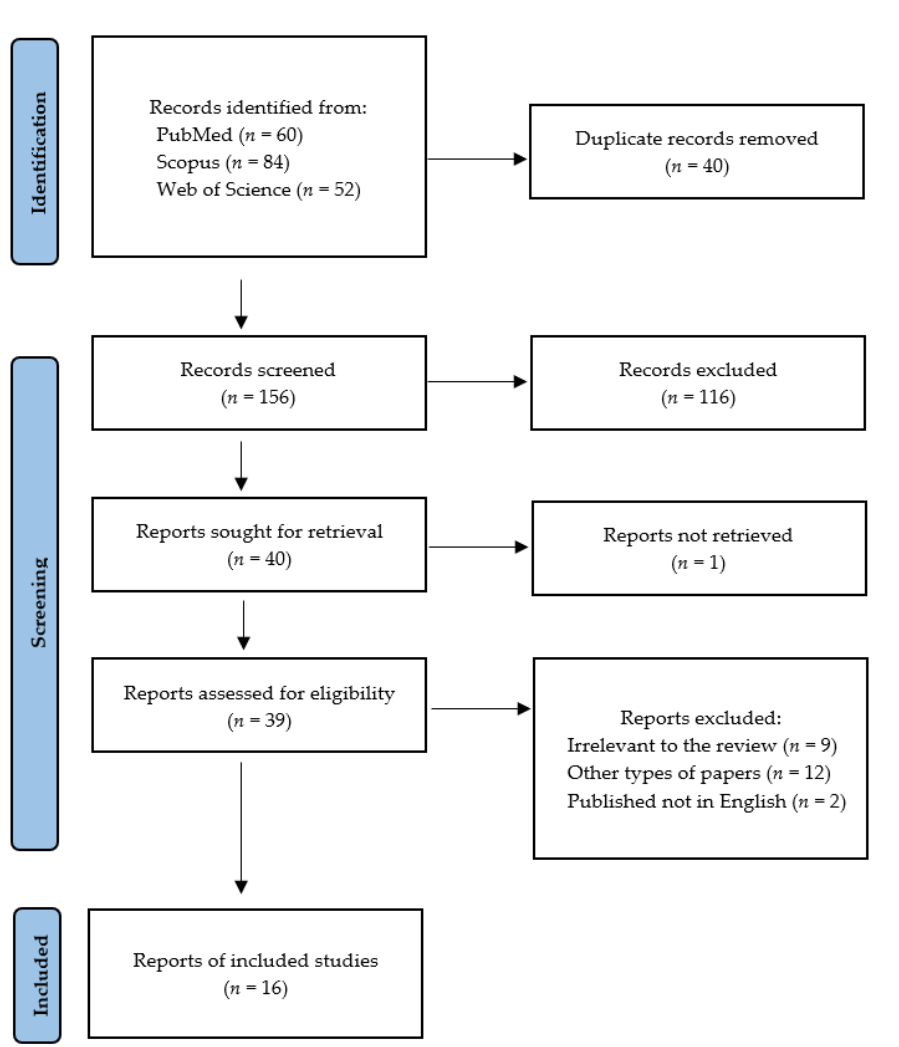
Figure 2. PRISMA flow diagram presenting search strategy.